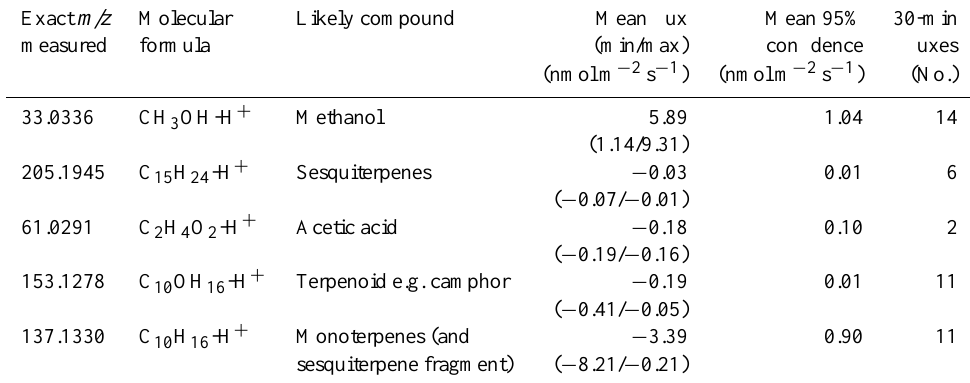
Table 2. VOC fluxes over intact grass during a sunny day 24h between 11:00CET on 1 August and 11:00CET on 2 August in 2009 in Neustift, Stubai valley. Fluxes were calculated from the half-hour concentration and wind covariance and only class-A fluxes, with a well defined maximum or minimum in the covariance, were taken into account. The 95% flux confidence is calculated from the mean noise of class-A fluxes. The No. of 30-min fluxes shows how many class-A fluxes (emission or deposition) were observed.